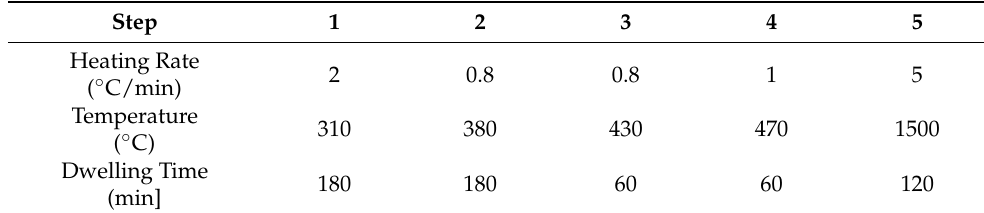
Table 2. Schedule for multi-step debinding with slow heating rates and sintering at 1500 °C for 2 h.